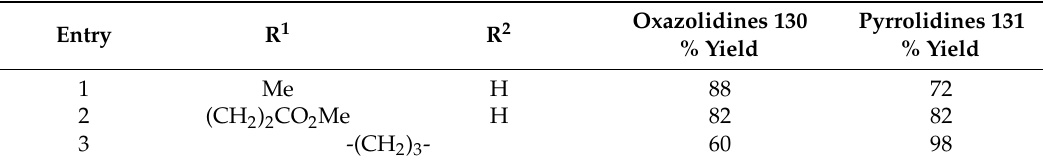
Table 18. Cycloaddition of azomethine ylide 129 to formaldehyde ( 2m ), and subsequent FVT-induced cycloreversion-intramolecular cycloaddition (Scheme 32).